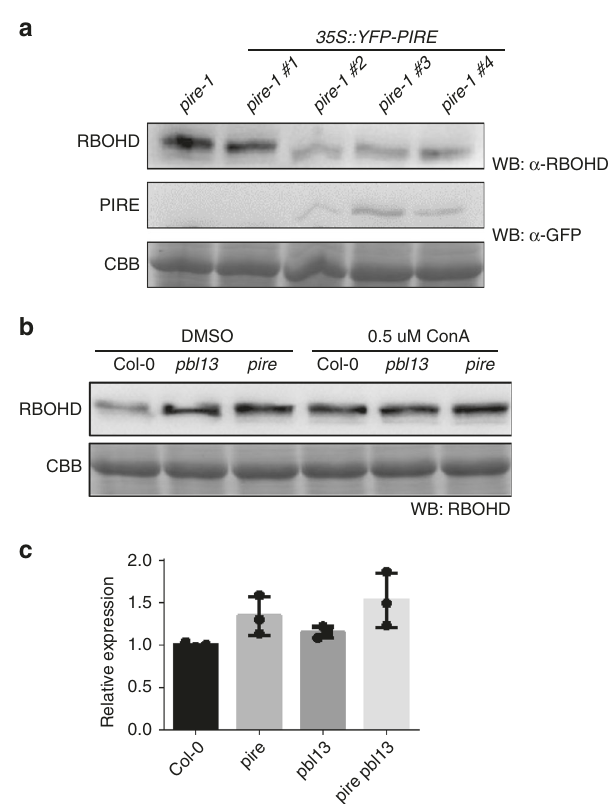
Fig. 5 RBOHD protein accumulation is reduced in PIRE overexpression lines and enhanced in pire and pbl13 knockout lines. a Arabidopsis transgenic lines expressing YFP-PIRE in the pire-1 knockout exhibited reduced accumulation of RBOHD compared to pire-1 knockout line. The expression of RBOHD and PIRE were detected by anti-RBOHD and anti-GFP immunoblotting. CBB coomassie brilliant blue. b The accumulation of RBOHD in pbl13 and pire knockout lines is not enhanced after inhibition of vacuolar degradation by Concanamycin A (ConA) treatment. Arabidopsis seedlings were treated with 0.5 µ M ConA for 18 h and RBOHD was detected by anti-RBOHD immunoblotting. c Transcript expression of RBOHD in Col-0, pire-1, pbl13-2 , and pire-1/pbl13-2 genotypes. cDNA samples from 10 days old plants were subjected to qPCR. Values represent relative expression compared to Col-0, means ± SD ( n = 3). Data were analyzed using the ΔΔ cT method, and normalized against Arabidopsis ELONGATION FACTOR 1 α (AT2G18720). No signi fi cant differences between genotypes were detected by ANOVA, α =